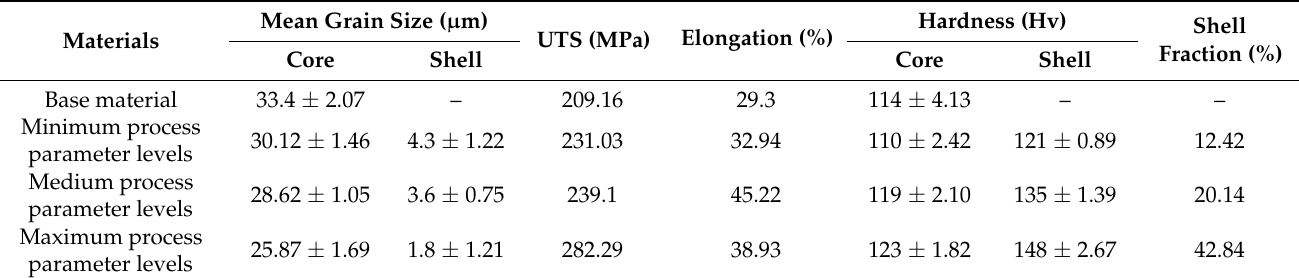
Table 3. Microstructural characteristics and mechanical properties of pure Cu specimens.